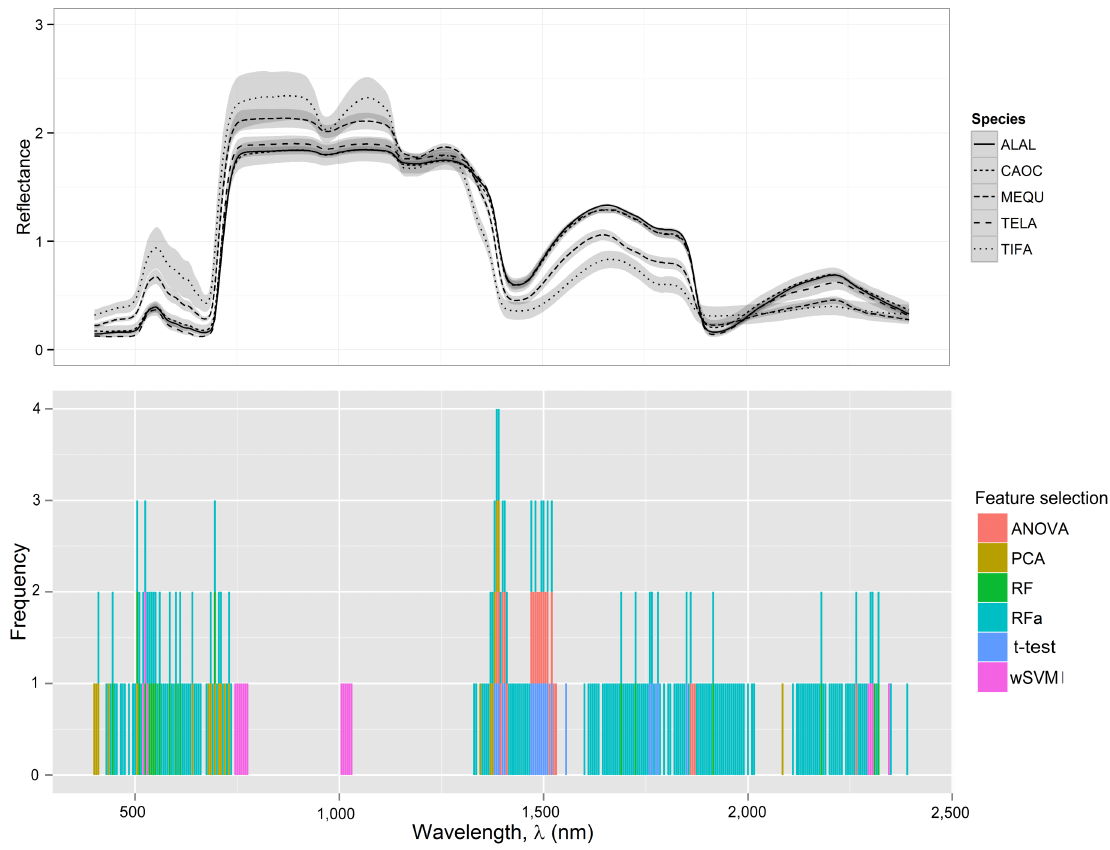
Figure 7. Selected regions where discriminating wavebands from the different feature selection methods occurred most frequently ( a ). The mean spectral reflectance curve for five ‘indicator’ species with different plant forms ( b ), with their respective 95% standard deviations shown for reference; the species are ALAL ( Alpinia allughas ), a tall grass, and MEQU ( Melaleuca quinquenervia ), a tree, both of which are invasive species. TELA ( Terminalia latifolia ) is a near threatened (International Union for Conservation of Nature ICUN, 1998) broadleaf species. TIFA ( Tillandsia fasciculate ) is a common epiphyte with a confined distribution within the Lower Morass. CAOC ( Calyptronoma occidentalis ) is a native shrub found mainly in the heavily disturbed swamp forest